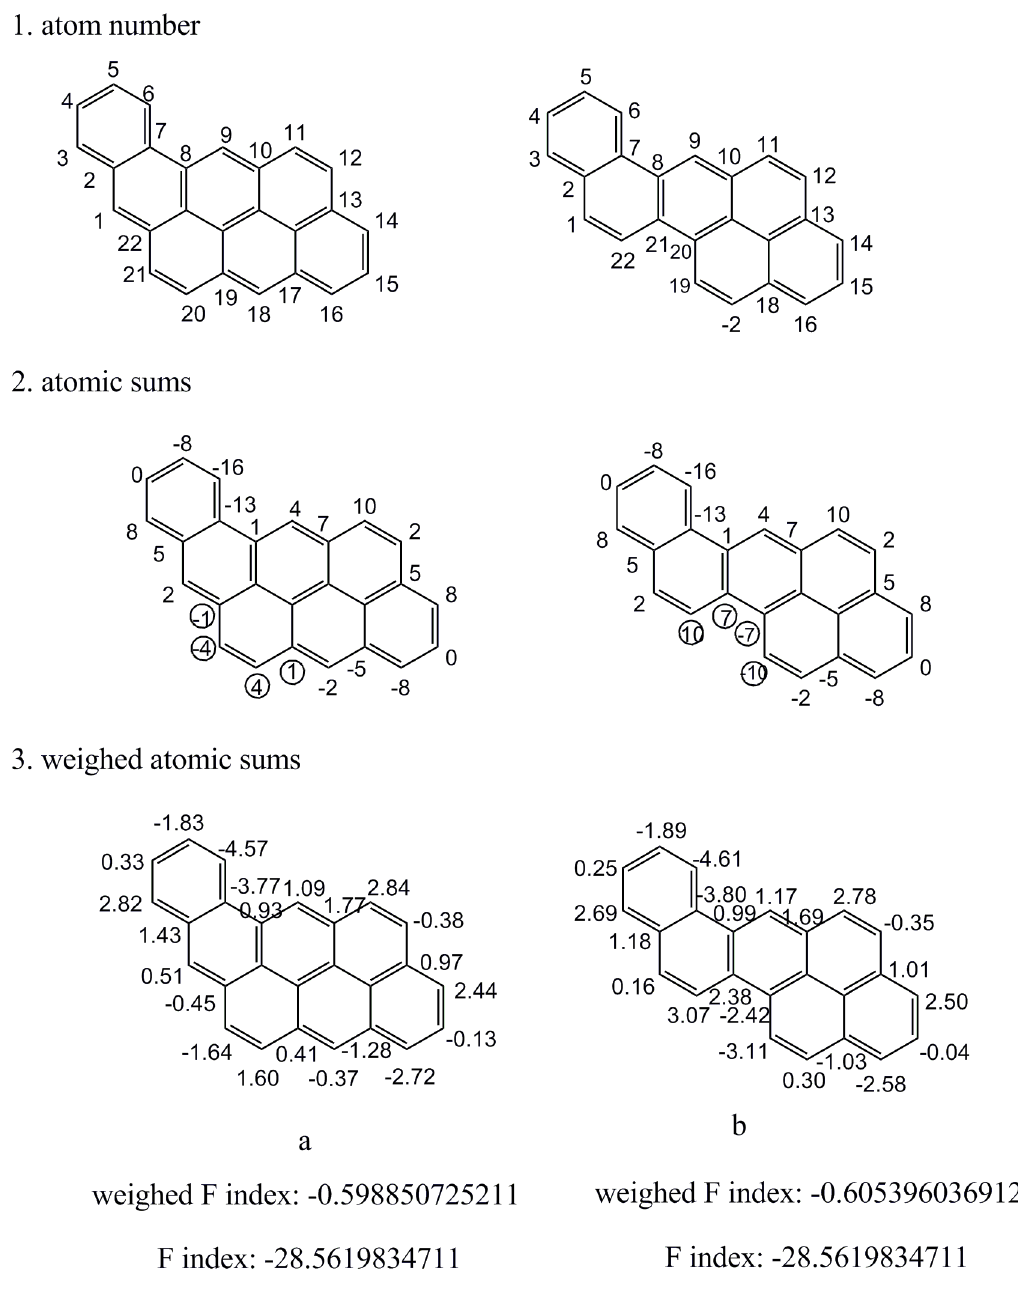
Figure 8. An illustration of two benzenoids possessing the same F indexes vector.